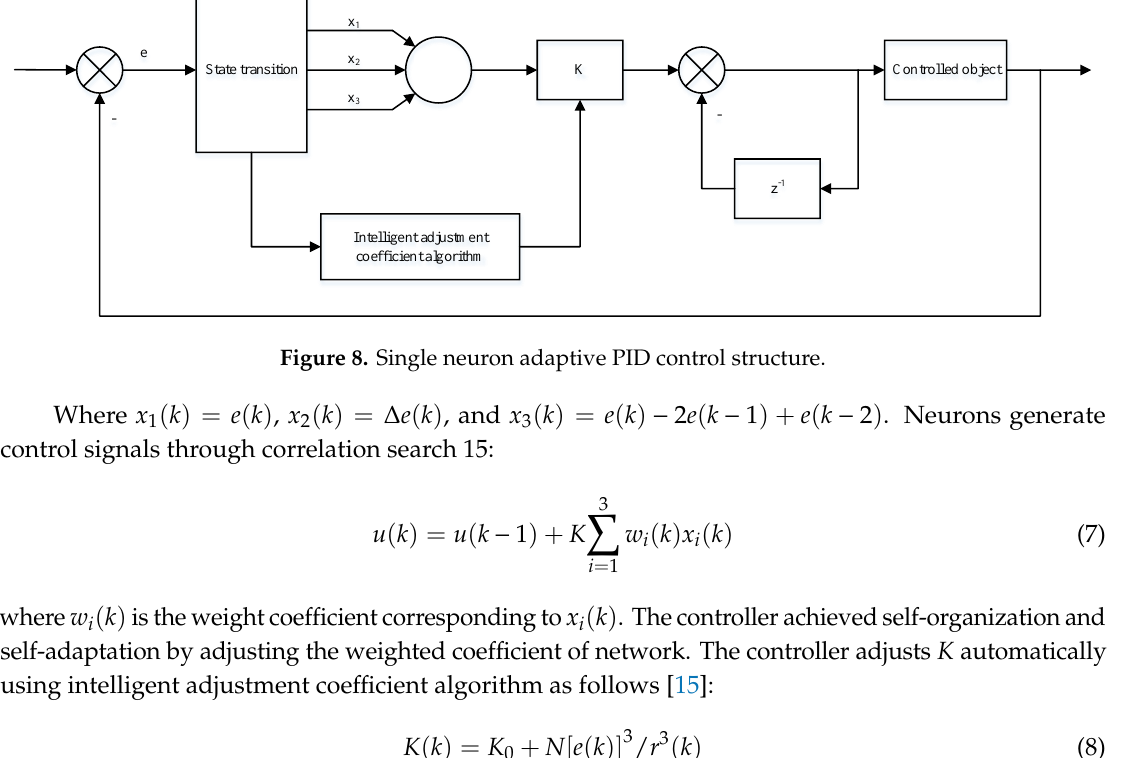
Figure 8. Single neuron adaptive PID control structure.